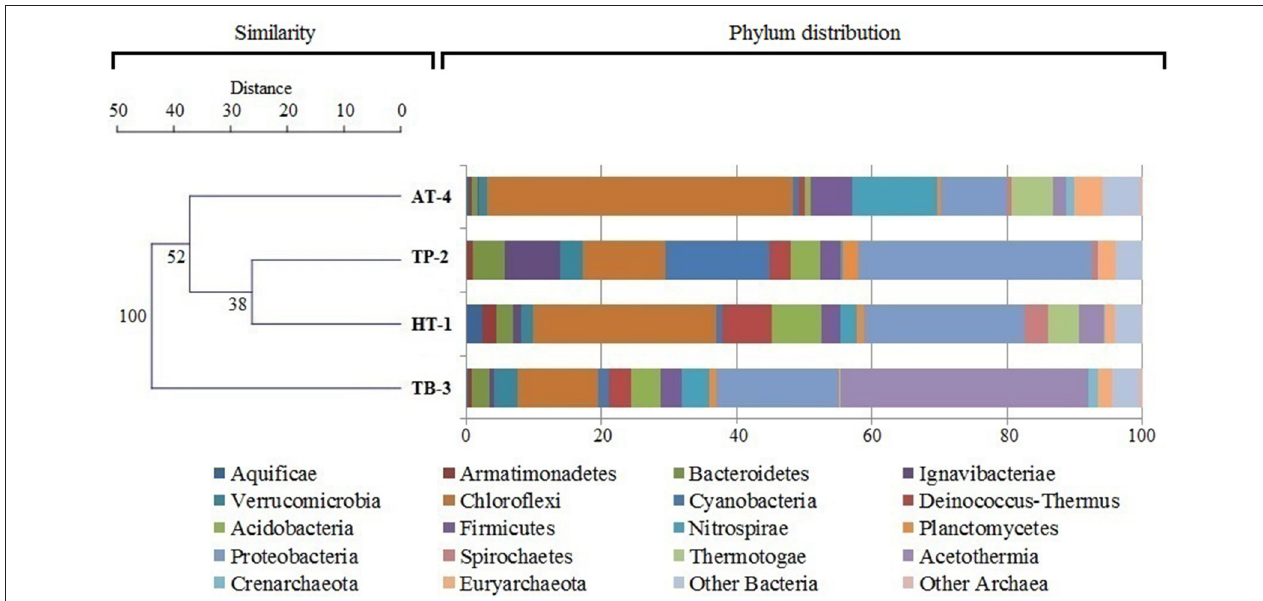
FIGURE 2 | Relative distribution of microbial phyla (both bacterial and archaeal) and hierarchical clustering of metagenomes. The phylum abundance data was obtained from MEGAN5 taxonomic classification of the protein-coding sequences in the metagenomes: HT-1 (Athamallik), TP-2 (Taptapani), TB-3 (Tarabalo), and AT-4 (Atri). The hierarchical clustering of the metagenomes was based on unweighted pair-group average (UPGMA) algorithm and Euclidean similarity index with 1000 bootstrap replicates.